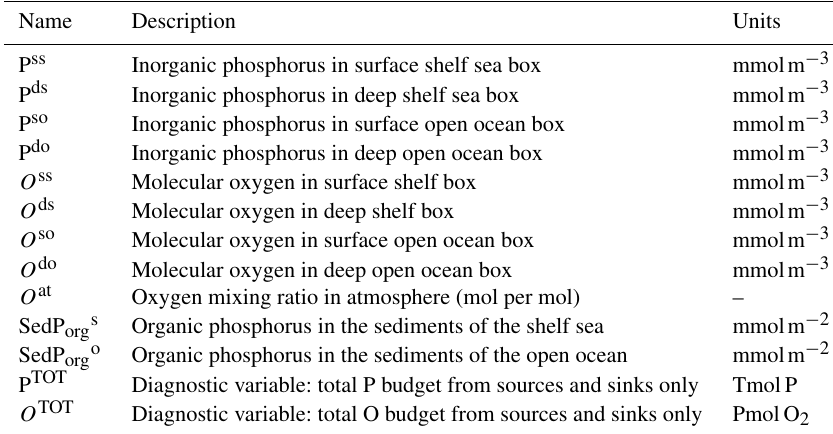
Table 1. List of the state variables in the model and of their units.